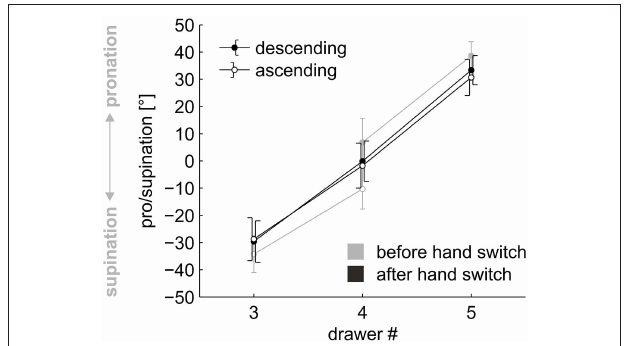
FIGURE 2 | Pro/supination angle for the ascending and descending sequences of trials at drawers #3, #4, and #5. Black lines depict postures after a hand switch, gray lines depict postures before a hand switch. Each data point represents the average across the factors “hand”, “repetition”, and “participant”. Error bars indicate 95 % confidence